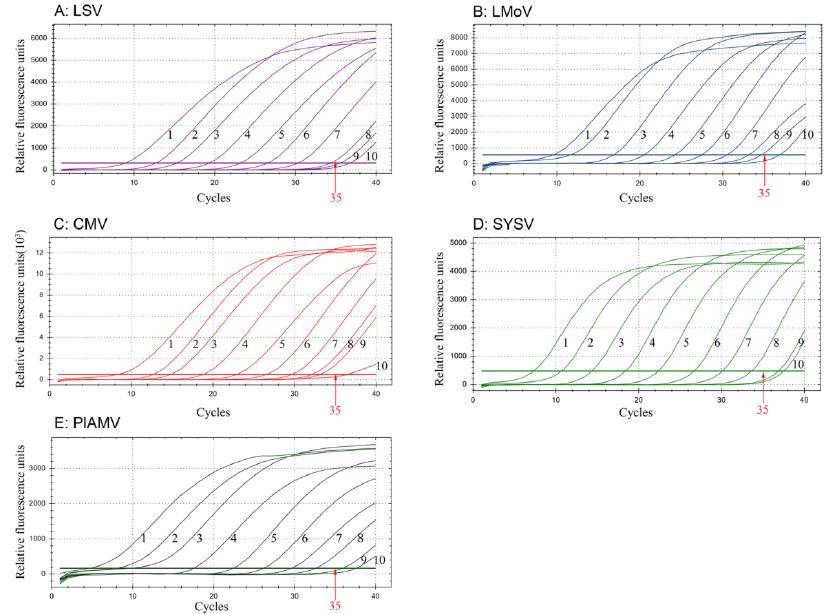
Figure 7. Sensitivity of the uniplex TaqMan real-time PCR assay for LSV ( A ), LMoV ( B ), CMV ( C ), SYSV ( D ), and PlAMV ( E ). 1–10, ten-fold serial dilutions of plasmid standard, with the concentrations from 1.33 × 10 9 to 1.33 × 10 0 copies · µ L − 1 , 1.27 × 10 9 to 1.27 × 10 0 copies · µ L − 1 , 1.28 × 10 9 to 1.28 × 10 0 copies · µ L − 1 , 2.33 × 10 9 to 2.33 × 10 0 copies · µ L − 1 , and 2.01 × 10 9 to 2.01 × 10 0 copies · µ L − 1 for LSV, LMoV, CMV, SYSV, and PlAMV,